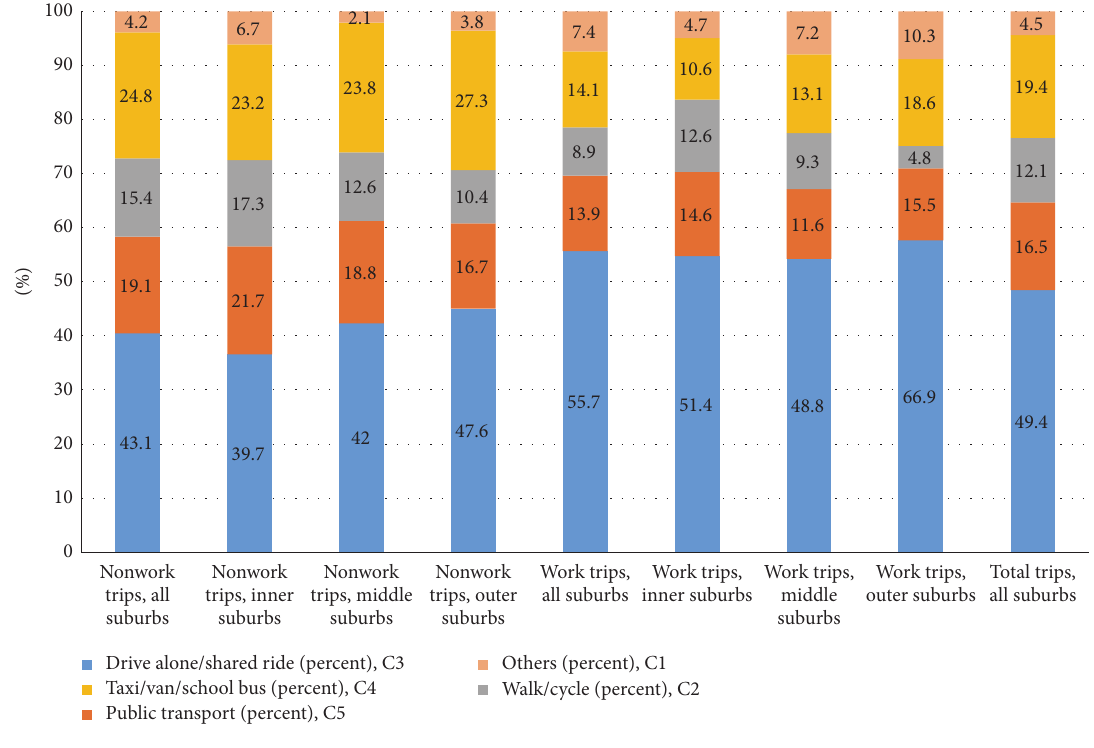
Figure 2: Modal choice among the three case study suburbs.